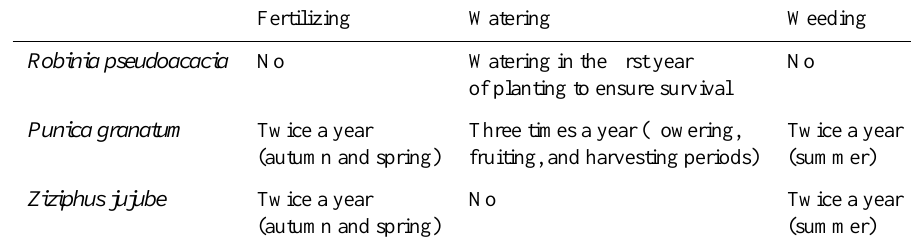
Table 2. The main management measures of plantations. Fertilizing Watering